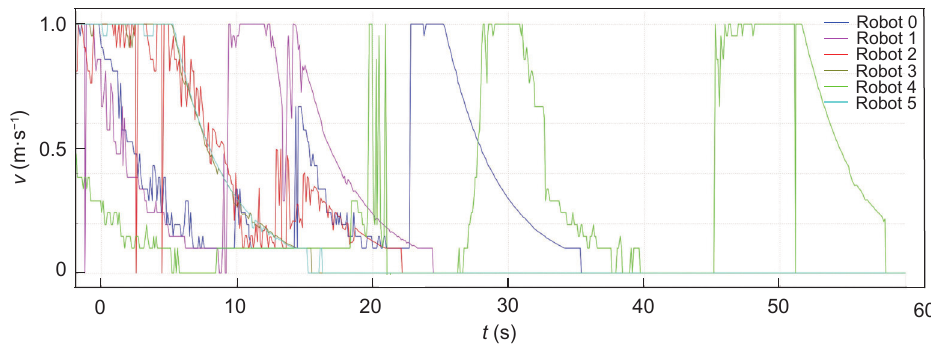
Fig. 16 Velocity evolution by using the DWA